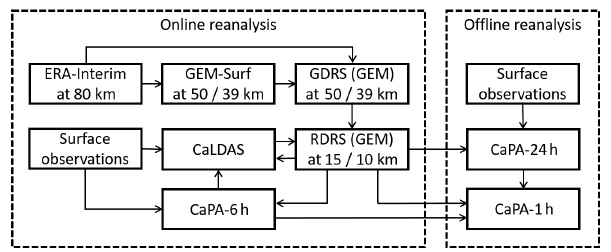
Figure 1. Scheme illustrating the main components of the method followed to produce a land-surface and precipitation